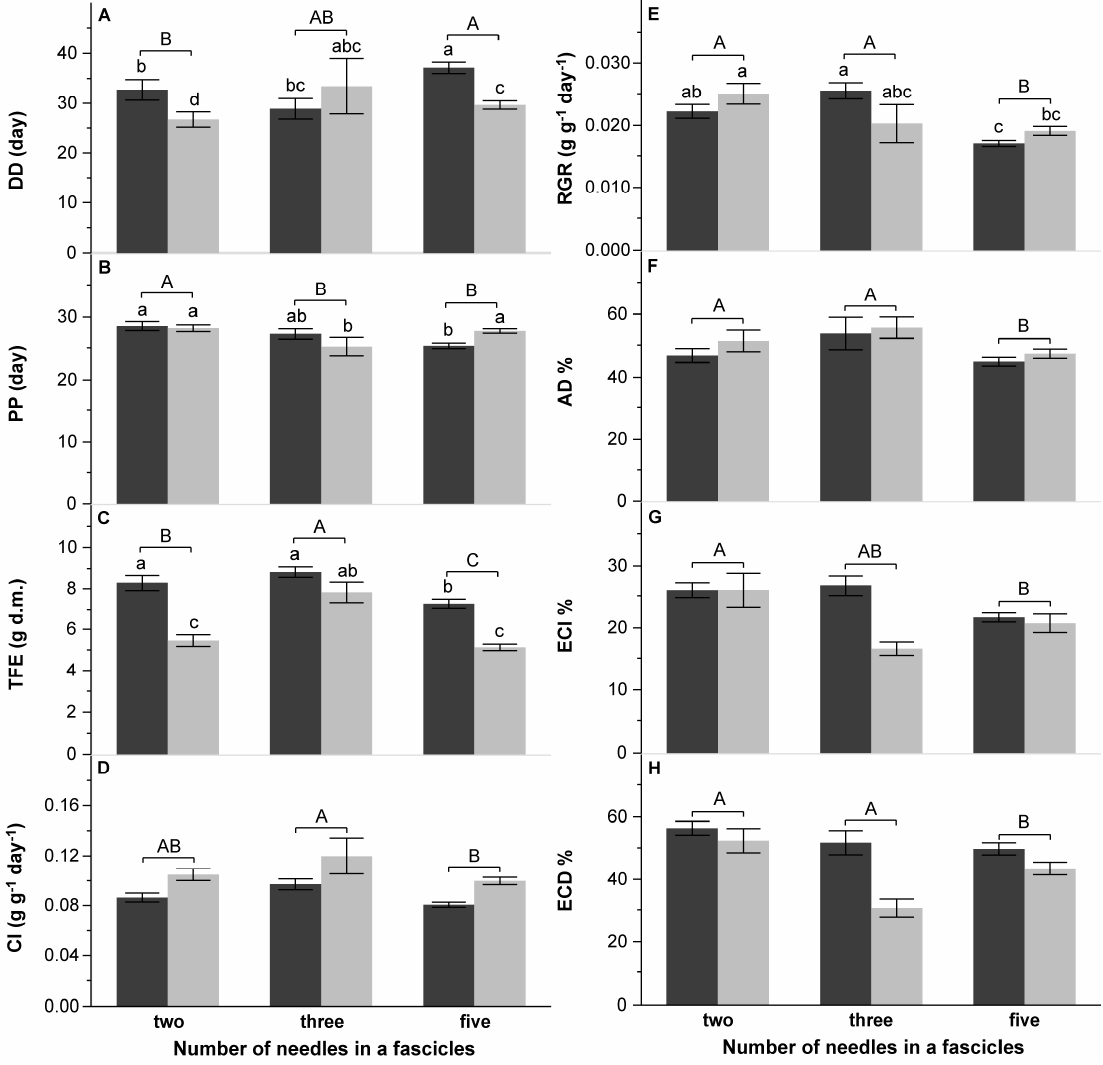
Figure 6. Mean values (±SE) of DD ( A ), PP ( B ), TFE ( C ), CI ( D ), RGR ( E ), AD ( F ), ECI ( G ), and ECD ( H ) achieved by the pine-tree lappet ( Dendrolimus pini L.) larvae, which were fed with needles of pine species with different numbers of needles in fascicles (two, three, and five) classified by sex: females (dark) and males (light). Lowercase letters above the bars indicate result of Tukey’s post hoc test ( α = 0.05) for interaction number of needles × month, and uppercase letters indicate result for number of needles in a fascicle treatment (see also Table 1). Levels not connected by same letter are significantly different.